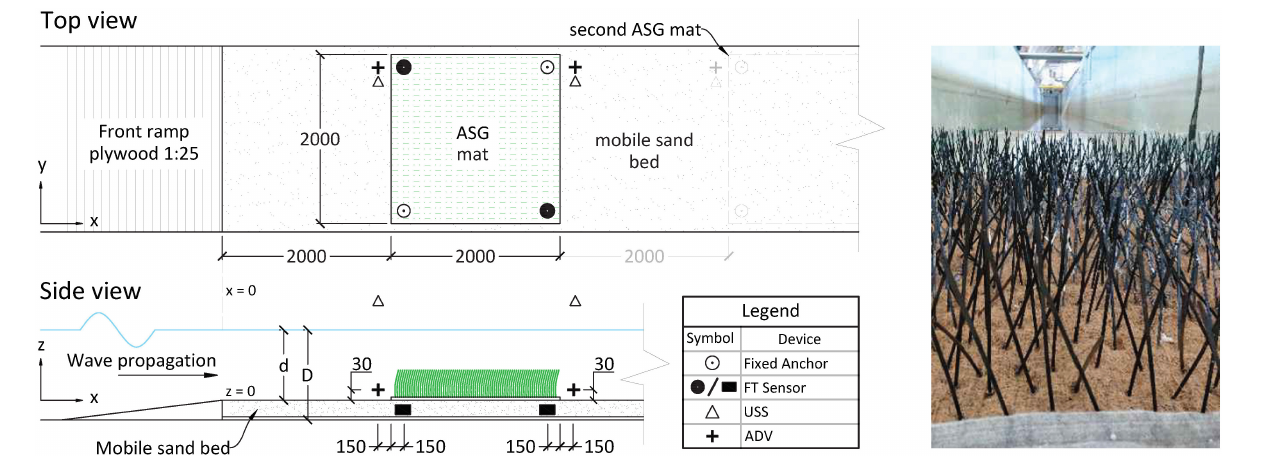
FIGURE 4 | (A) Schematic of the experimental set-up for ASG coir mats (1-mat set-up, 2 nd mat shown dimmed). z -scale is exaggerated; all dimensions given in mm. (B) Close-up image of an ASG mat in the